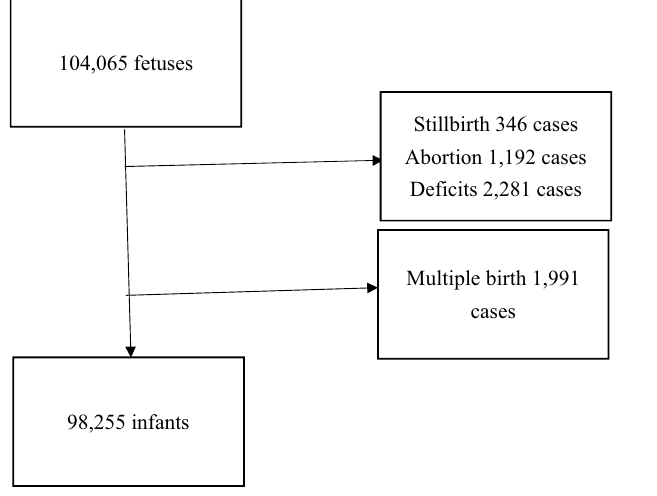
Figure 1. Enrollment chart.